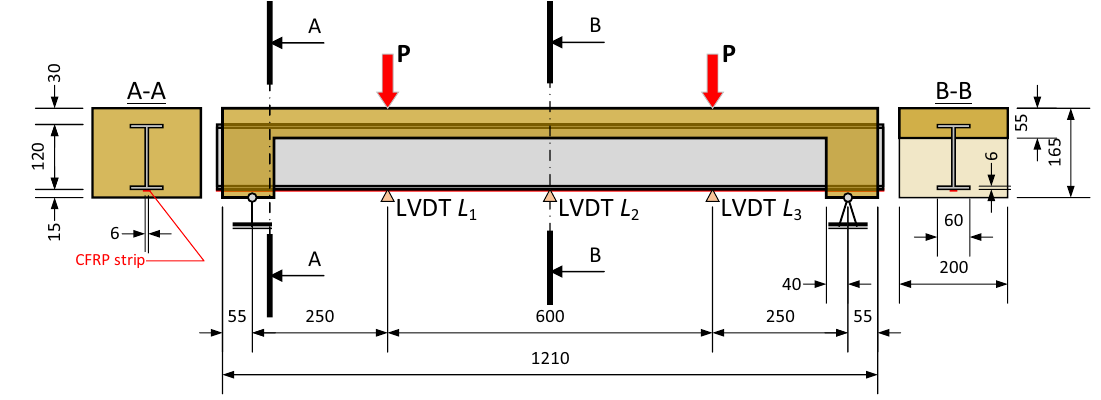
Figure 1. The hybrid beam schematic and anticipated